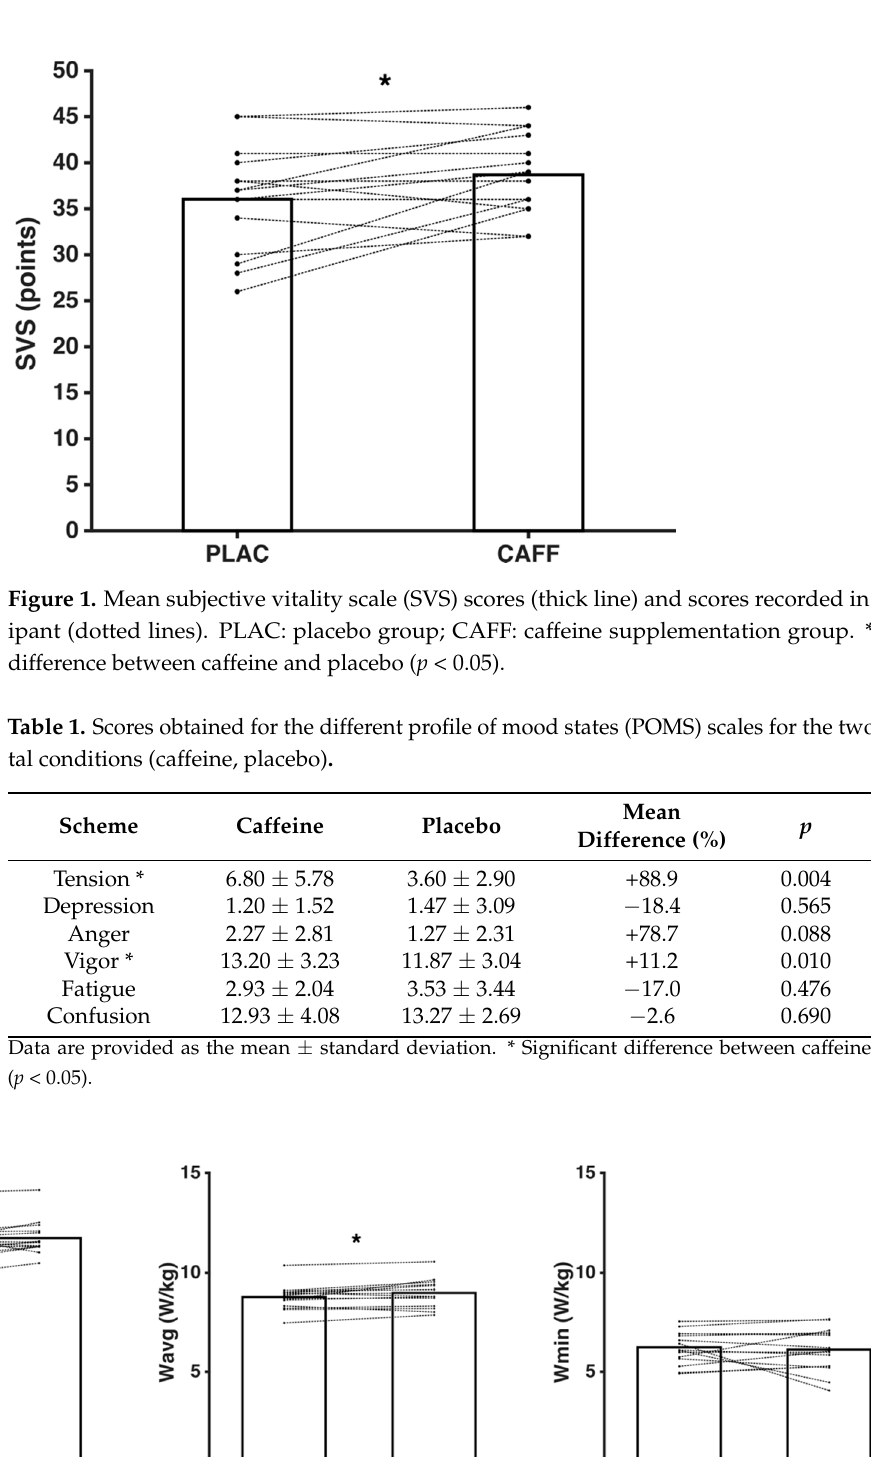
Figure 2. Power (W/kg) variables Wmax, Wavg, and Wmin recorded under placebo and caffeine experimental conditions. PLAC: placebo group; CAFF: caffeine supplementation group. * Significant difference for placebo vs. caffeine ( p < 0.05).